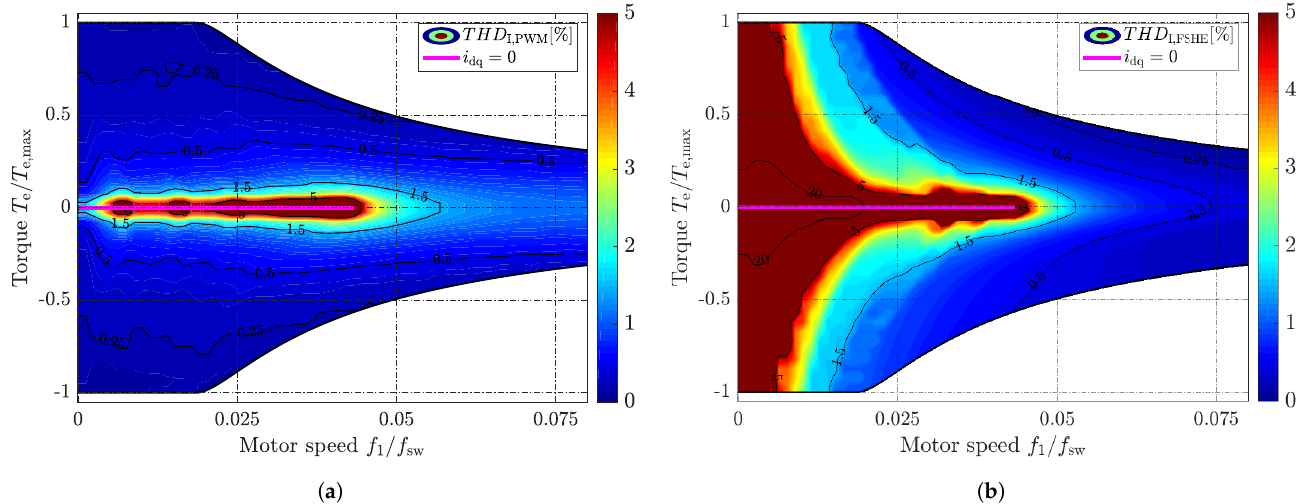
Figure 10. Simulated current THD I for the entire drivetrain operating range for ( a ) multilevel PWM and ( b ) FSHE.